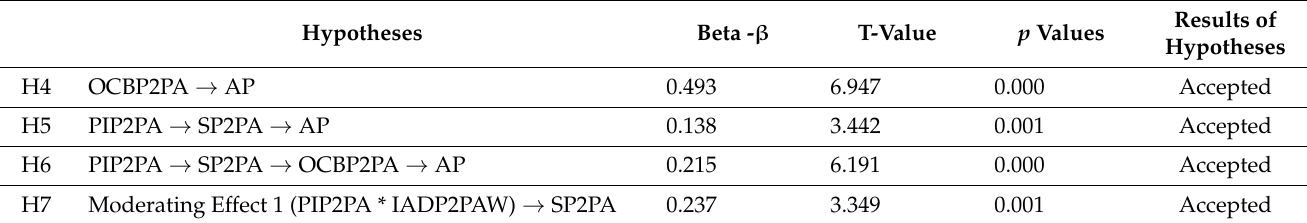
Table 5. The structural model’s results.